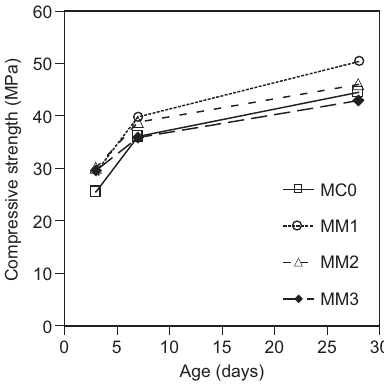
Figure 3 Compressive strength developments of cement mortars vs. the montmorillonite contents.